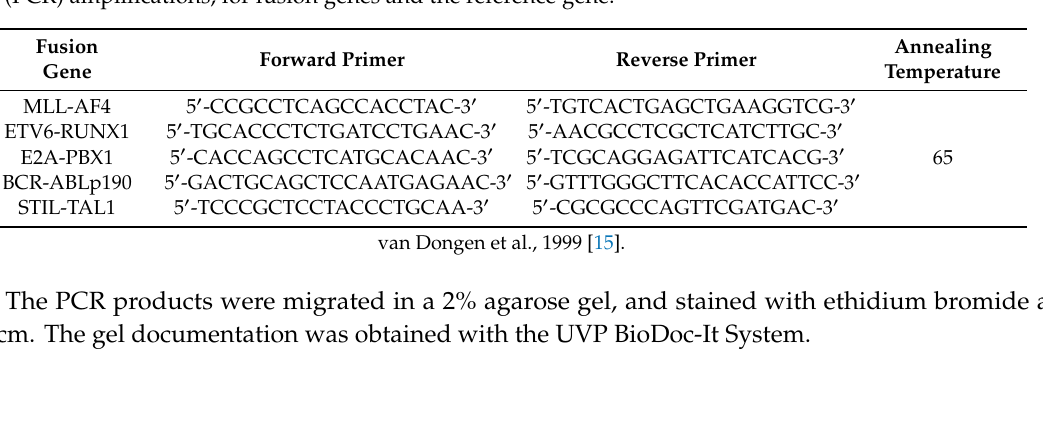
Table 1. Sequences and annealing temperatures for primer sets used for polymerase chain reaction (PCR) amplifications, for fusion genes and the reference